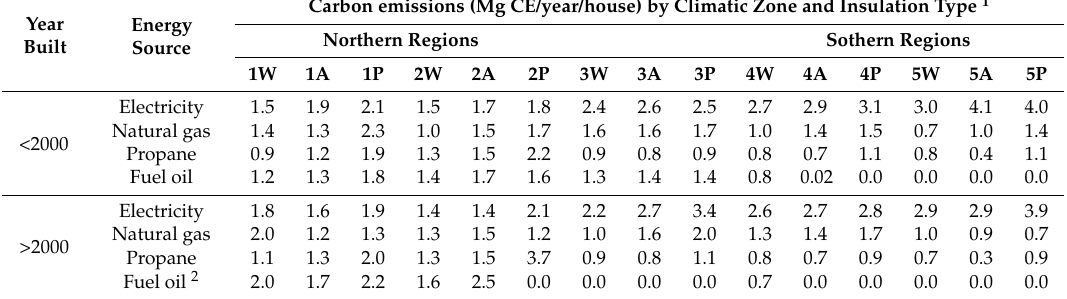
Table 2. Carbon equivalent (CE) emissions for rural houses built before and after 2000 using different energy sources and insulation types in different climatic zones.